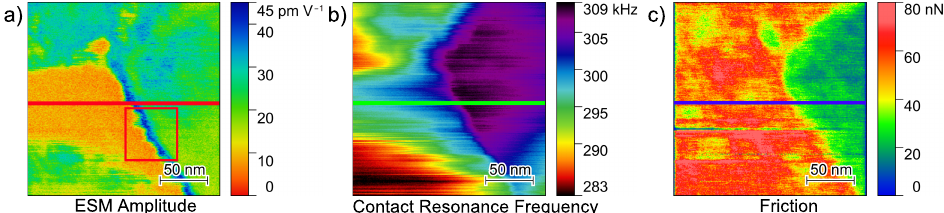
Figure 5. ( a ) Amplitude, ( b ) contact resonance frequency and ( c ) friction force images of a − LiTFSI and a single LLZO:Ta particle. The line 200 nm × 200 nm area between the bulk PEO 6 sections indicated in the middle of the images are shown in Figure 6.